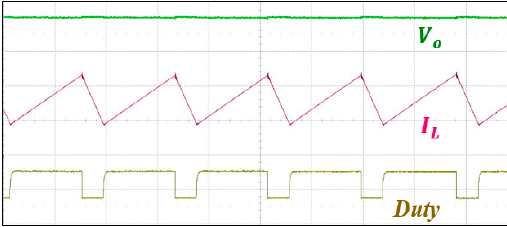
Figure 28. Inductor current waveform after a rise in output voltage. (10 V/div, 1A/div, 25 us/div).